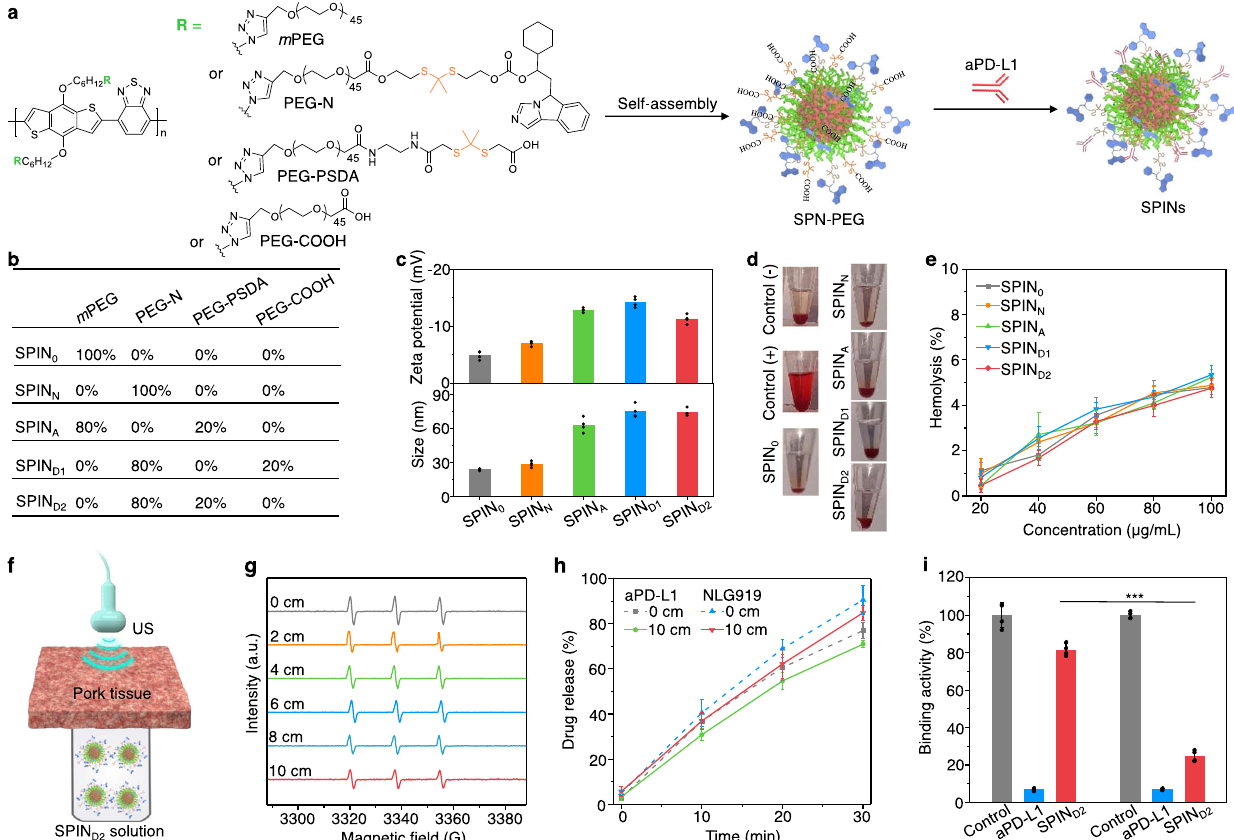
Fig. 3 Synthesis, characterization, and sonodynamic activation of SPINs. a Chemical structures of amphiphilic semiconducting polymeric modulators and schematic illustration of their self-assembly and surface modi fi cation to form SPINs. b The molar ratios of each component in different SPINs. c Zeta potentials and hydrodynamic sizes of different SPINs in 1× PBS buffer (pH = 7.4) ( n = 4). d Photographs of erythrocytes after incubation with 1× PBS buffer (negative control), 1% Triton X-100 (positive control), and 1× PBS buffer containing SPINs at the concentration of 100 µ g/mL for 2 h, followed by centrifugation. e Hemolysis percentages of erythrocytes after incubation with SPINs at different concentrations for 2 h ( n = 4). f Schematic illustration of US irradiation of SPIN D2 solutions covered with a pork tissue. g ESR spectra of 1 O 2 for SPIN D2 (20 µ g/mL) after US irradiation (1.2 W/cm 2 , 3 min) without or with coverage of pork tissues at different thicknesses. h Release pro fi les of aPD-L1 and NLG919 from SPIN D2 (40 µ g/mL) after US irradiation for different time ( n = 4). i PD-L1/PD-1 binding activity assay after treatment with free aPD-L1 or SPIN D2 (40 µ g/mL) with or without US irradiation ( n = 4). SPIN D2 – US versus SPIN D2 + US: P < 0.0001. Statistical signi fi cance was calculated via a two-tailed Student ’ s t test. *** P < 0.001. In ( g – i ), the power intensity of US irradiation was 1.2 W/cm 2 (1.0 MHz, 50% duty cycle). Data are presented as mean values ± SD. Source data are provided as a Source Data fi